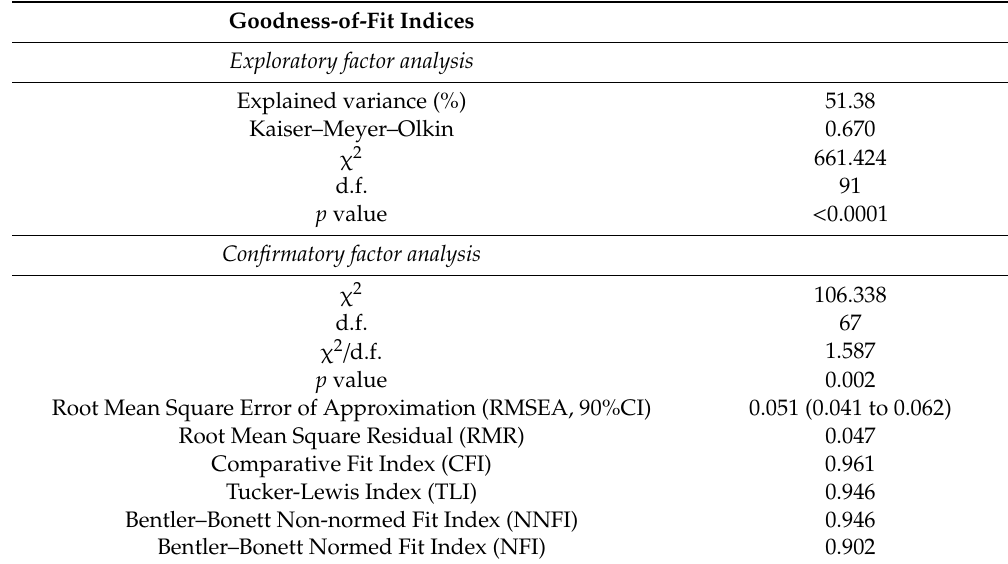
Table 4. Goodness-of-fit indices for exploratory / confirmatory factor